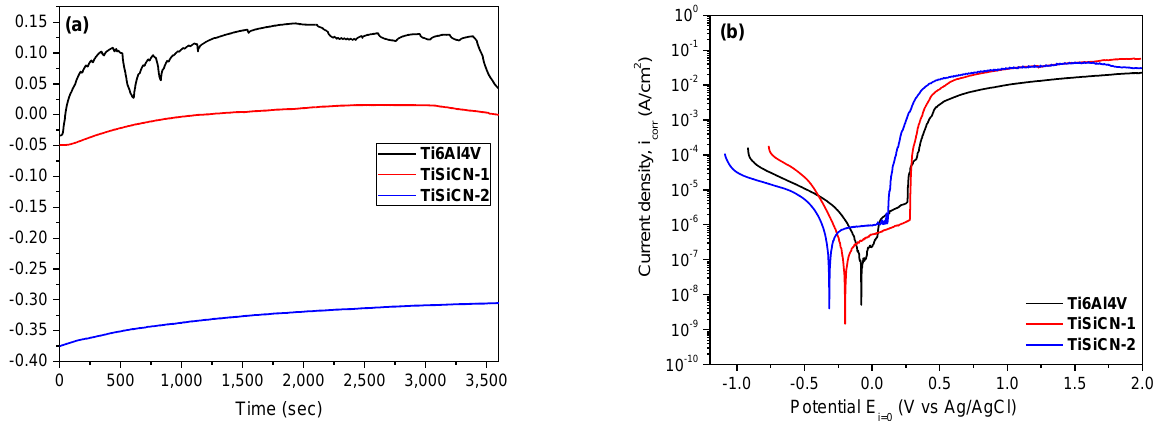
Figure 5. ( a ) Open circuit curves and ( b ) potentiodynamic polarization curves of the investigated surfaces after 1 h immersion in 3.5% NaCl.